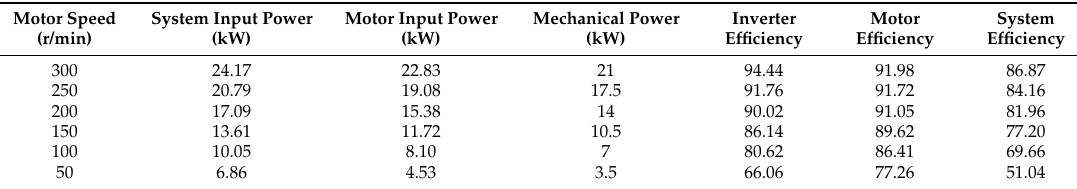
Table 3. Experimental results at rated torque in the MTPA control.